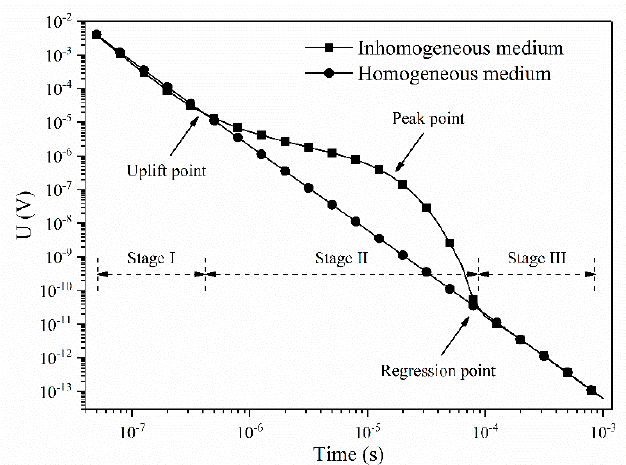
Figure 11. Comparison of homogeneous and inhomogeneous whole-space